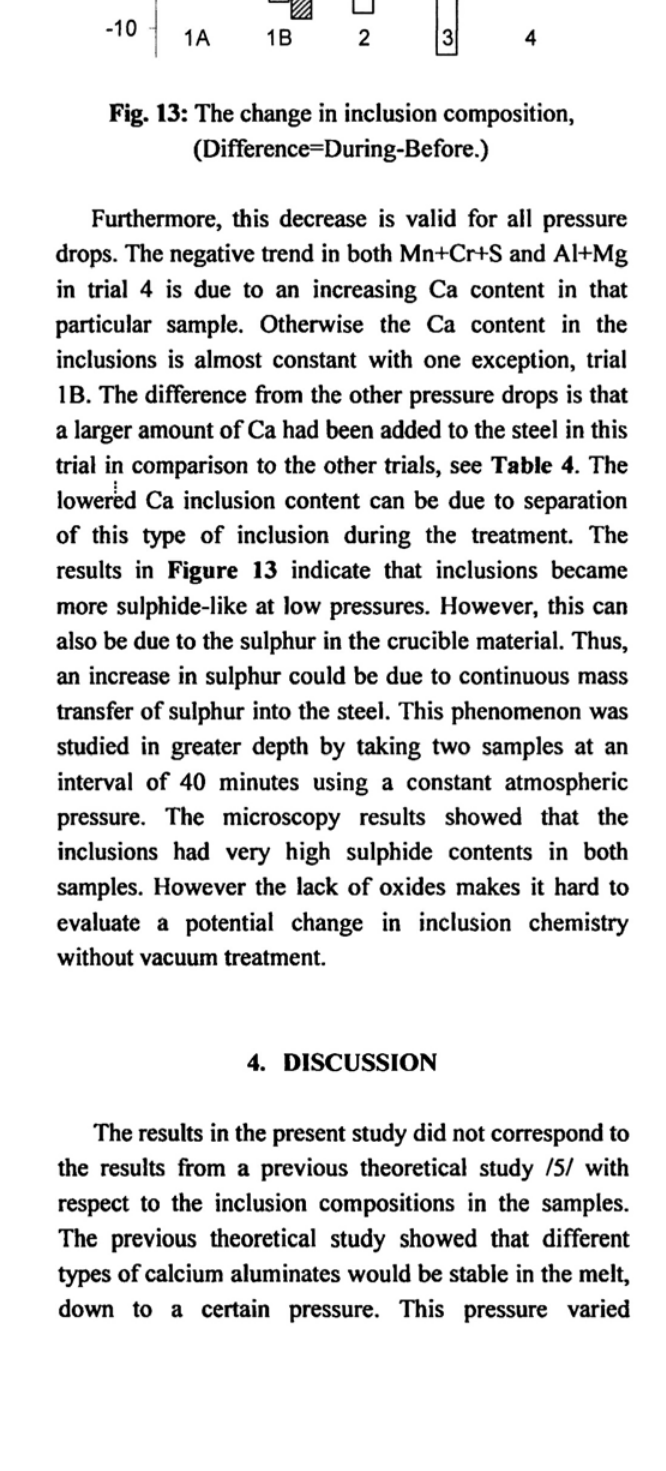
Fig. 13: The change in inclusion composition,